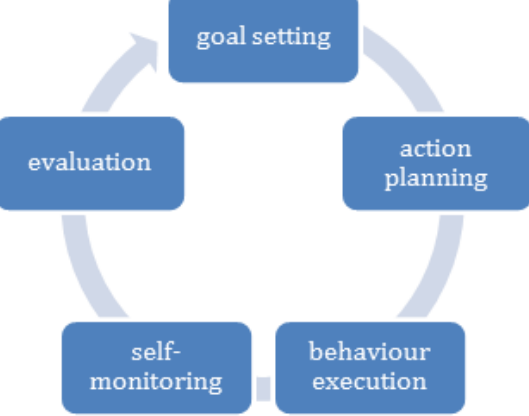
Figure 1. Behavior change through